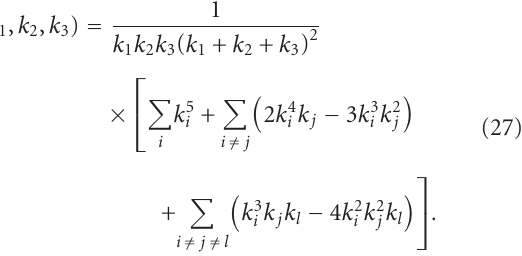
Table 1: Shape correlations (19) and CMB correlations (61) between the equilateral family of primordial models. DBI Ghost Single C ( S , S (cid:9) ) C ( B , B (cid:9) ) C ( S , S (cid:9) ) C ( B , B (cid:9) ) C ( S , S (cid:9) ) C ( B , B (cid:9) ) Equilateral 0.99 0.99 0.98 DBI 0.94 0.95 0.98 0.99 Ghost 0.86